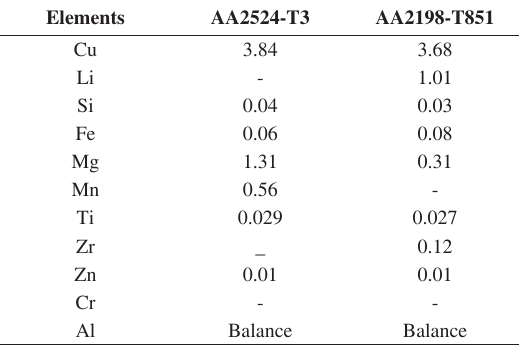
Table 1. Chemical composition (wt %) of the aluminum